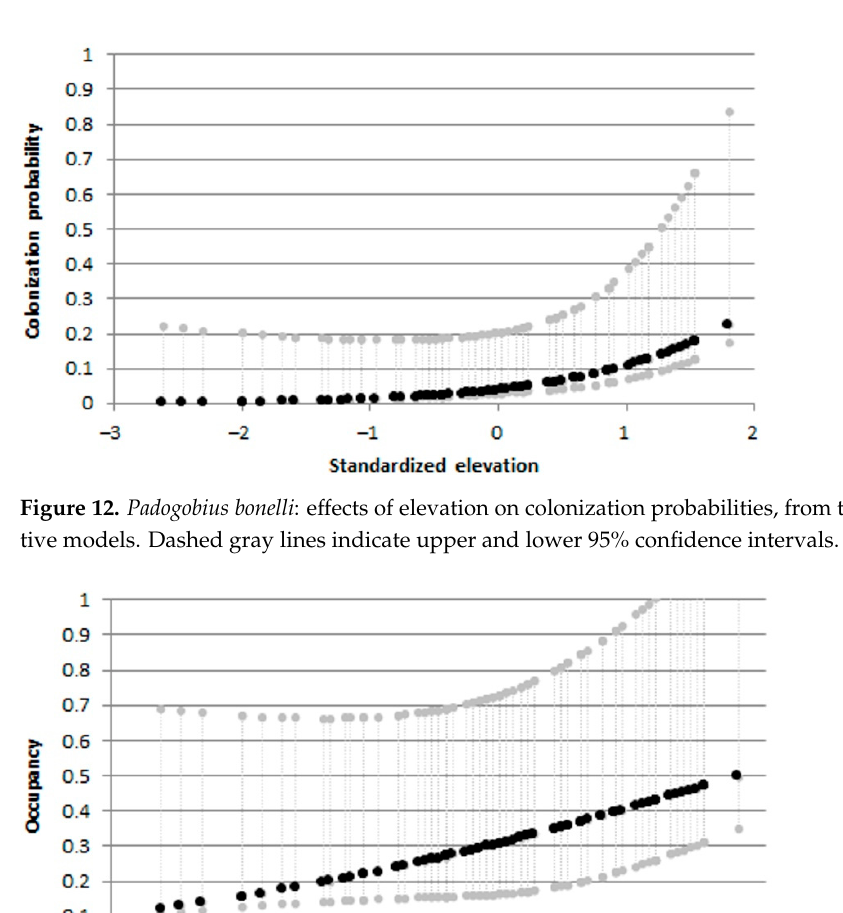
Figure 11. Gobio gobio : effects of average current speed on colonization probabilities from the best informative models . Dashed gray lines indicate upper and lower 95% confidence intervals.